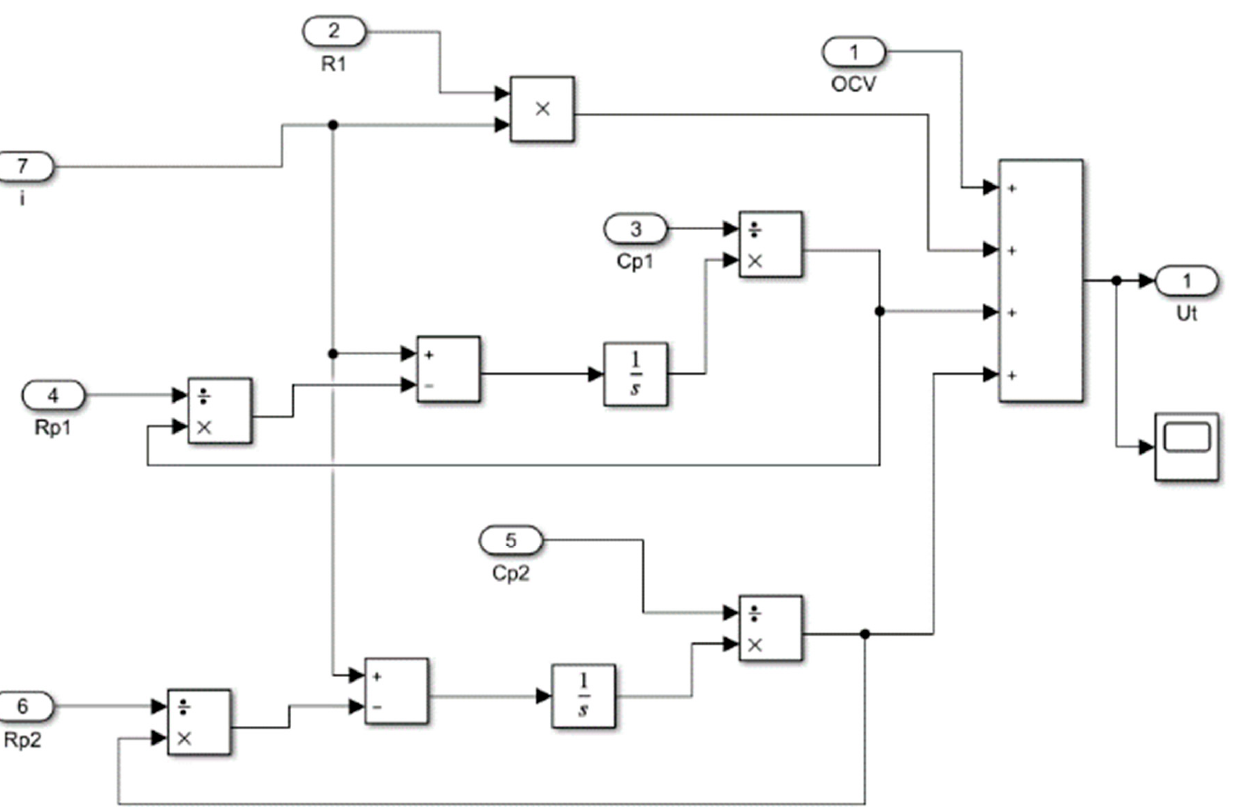
Figure 2. Simulation model for the second order RC circuit.